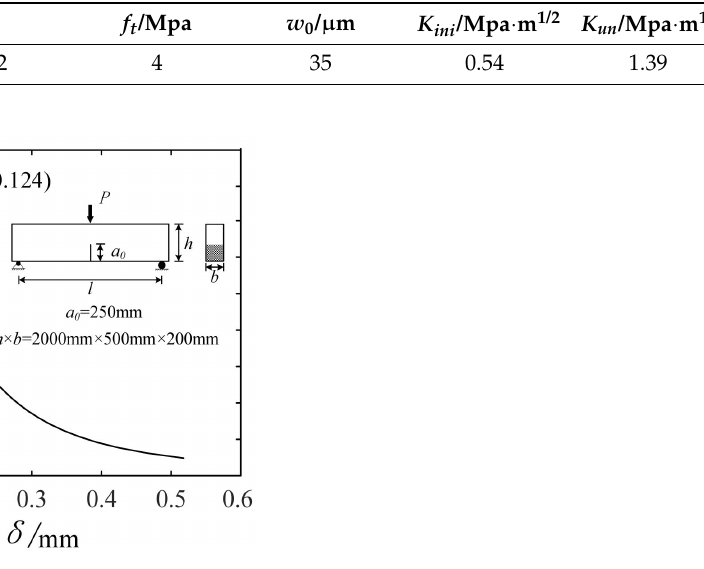
Figure 7. P– δ curve of the bending